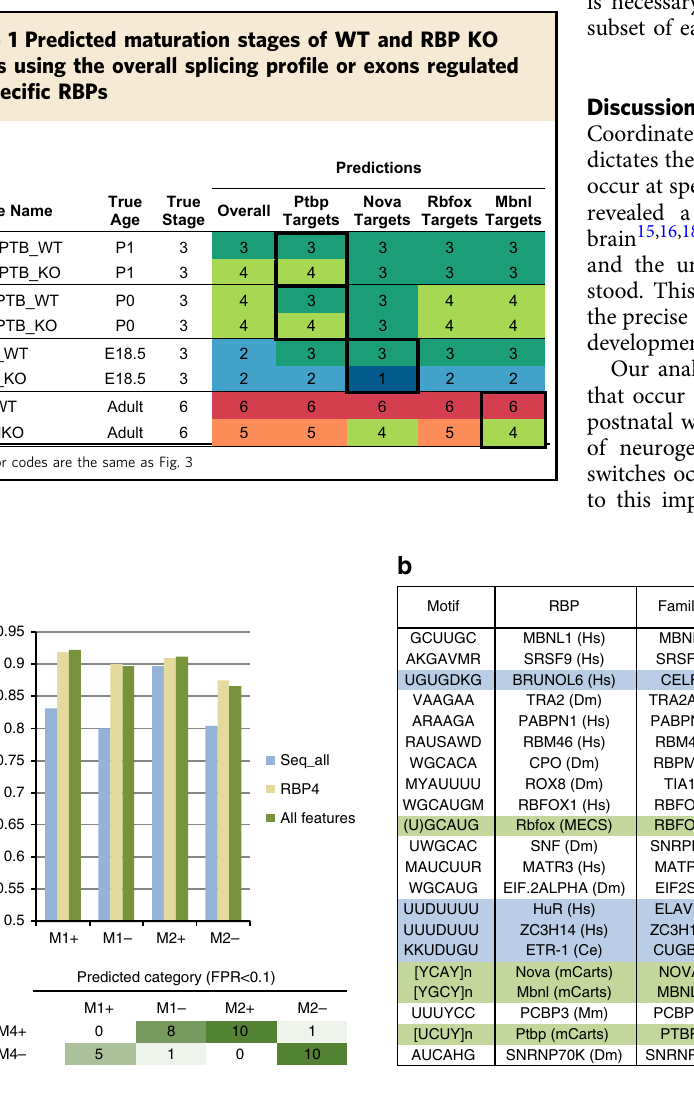
Fig. 5 A neurodevelopmental splicing code predicts early and late splicing switches. a Performance of prediction as measured by AUC. Four models were trained to predict exons in modules M1 and M2. Exons with increased inclusion or exclusion were predicted by separate models. Different sets of features were used to build models. b Importance of RBP motifs for prediction in each model. Motif sites in the upstream intron (UI), exon (E), and downstream intron (DI) were scored separately. Only motifs ranked among the top 100 features in at least one region are shown. Motifs enriched in speci fi c regions are shown in red and motifs depleted are shown in blue. c Summary of prediction results for exons in module M4 indicating that the two developmental splicing switches of these exons can be predicted